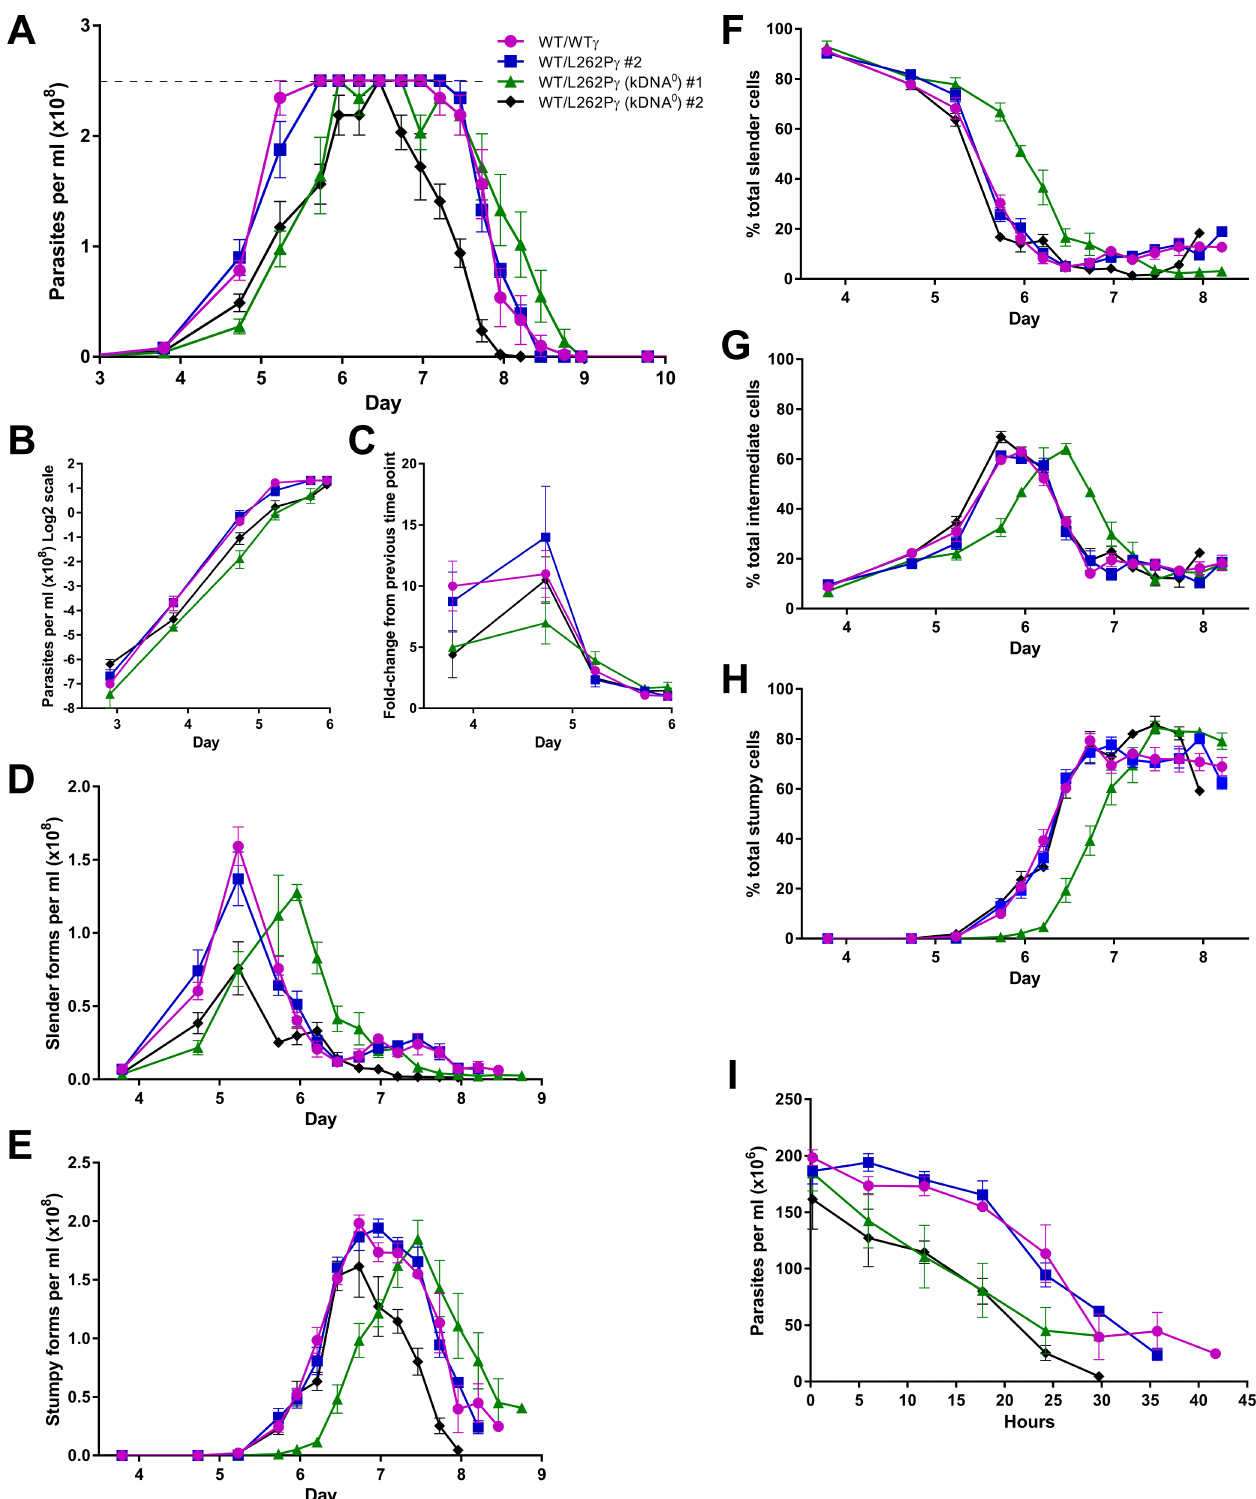
Fig 2. Stumpy forms lacking kDNA persist for a reduced time span during the first peak of parasitaemia. (A) Parasitaemia during mouse infections was measured over time. Mice were infected at day 0, with four mice infected per cell line. Error bars are standard error of the mean (SEM). Tail snips were performed every 6 h from day 4 to day 10 post infection and cell counts were estimated from blood smears. Dashed grey line indicates accurate detection limit